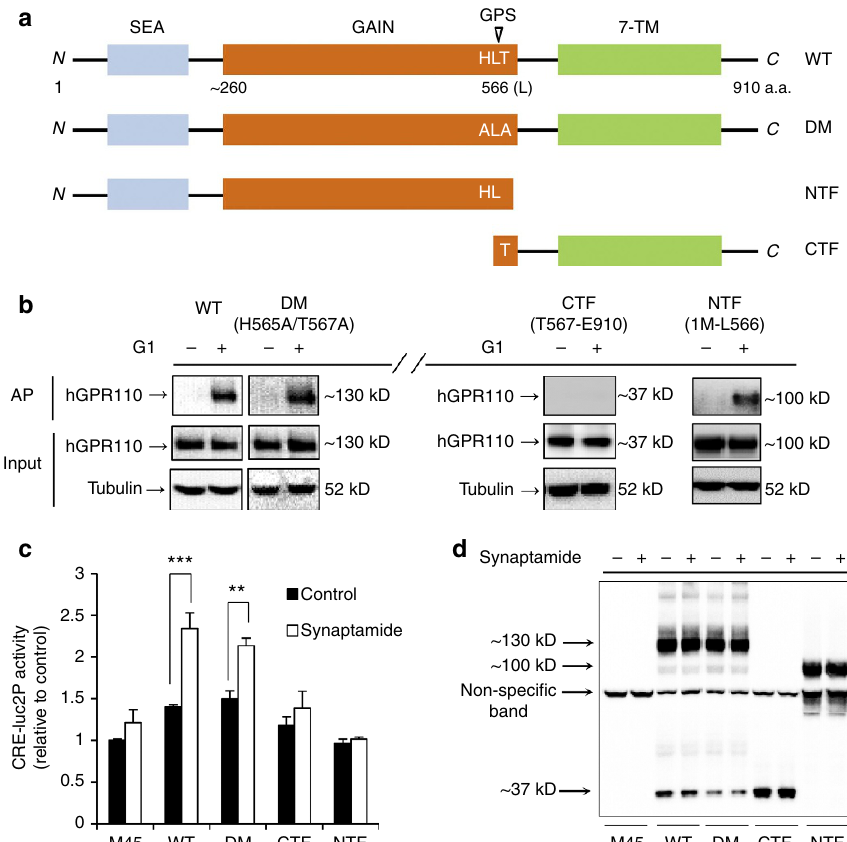
Figure 4 | Significance of GPR110 N -terminus in ligand binding and synaptamide-induced cAMP production. Human GPR110 sequence map shows wild type full size hGPR110 (1–910, WT), GPS cleavage sequence (HL^T) double mutant (H565A/T567A, DM), N -terminal fragment (1–566, NTF) and C -terminal fragment (567–910, CTF) ( a ). When the N -terminus was truncated (CTF), neither binding of synaptamide analogues G1 to hGPR110 ( b ) nor synaptamide-induced cAMP production ( c ) was observed, while the C -terminal truncated form, NTF, showed G1 binding. Double mutation at GPS (DM) to prevent the autocleavage did not alter the ligand binding ability or synaptamide-induced cAMP production. The treatment with 10nM synaptamide did not affect hGPR110 autocleavage ( d ). To evaluate cAMP production, various mutant forms of hGPR110 were transiently overexpressed in HEK293 cells permanently expressing CRE-luc2P as a cAMP sensor and treated with 10nM synaptamide for 16h. M45: empty vector expressing cells. Data represent three independent experiments ( b – d ). Values in c are means ± s.e.m. of biological triplicates ( n ¼ 3). *** P o 0.001 versus the